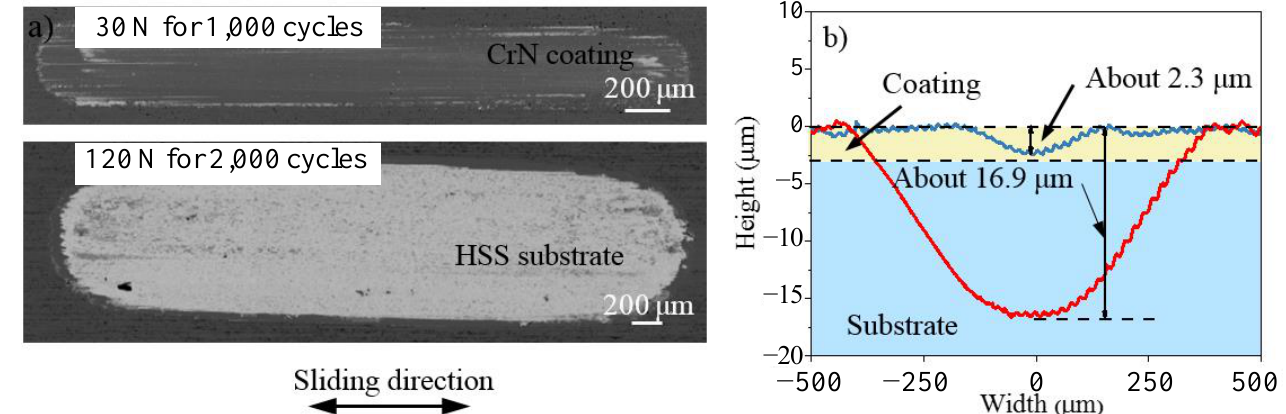
Figure 6. ( a ) SEM of wear scars and ( b ) profiles of CrN coated HSS substrate.